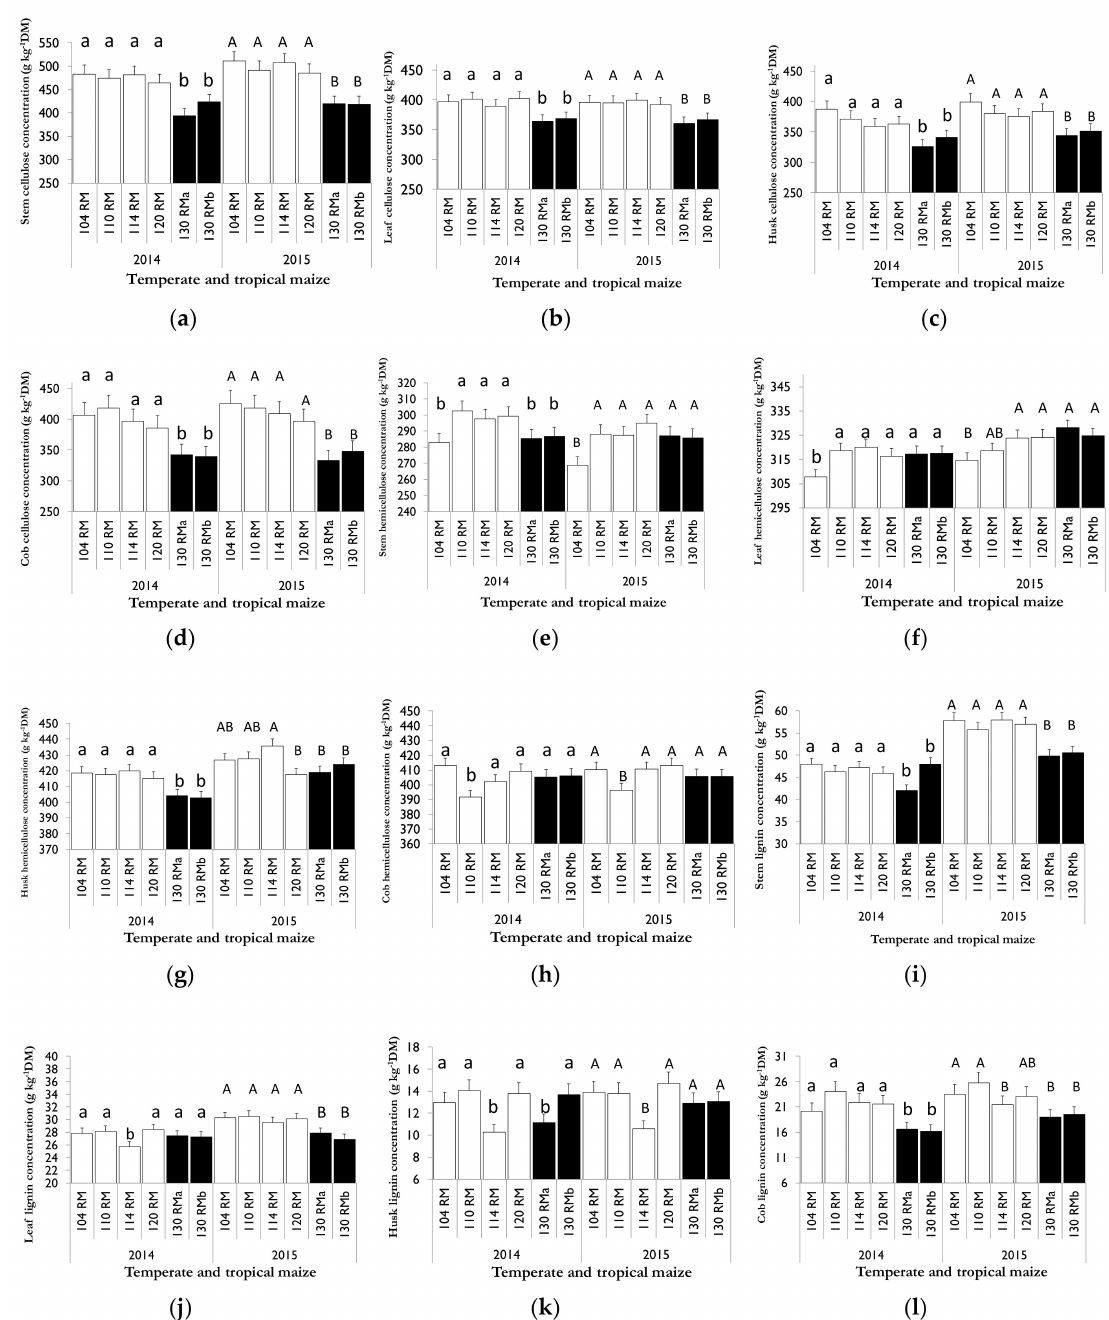
Figure 3. Differences in ( a – d ) cellulose, ( e – h ) hemicellulose, and ( i – l ) lignin concentrations among temperate and tropical maize by stems, leaves, husks, and cobs during 2014 and 2015 in Boone County, IA. Treatments were determined within each year. RM stands for relative maturity type, and two different RM ( a , b ) are presented when corn of relative maturity of 130 is evaluated. Different letters on the top of standard error bars mean significant differences among treatments ( p >